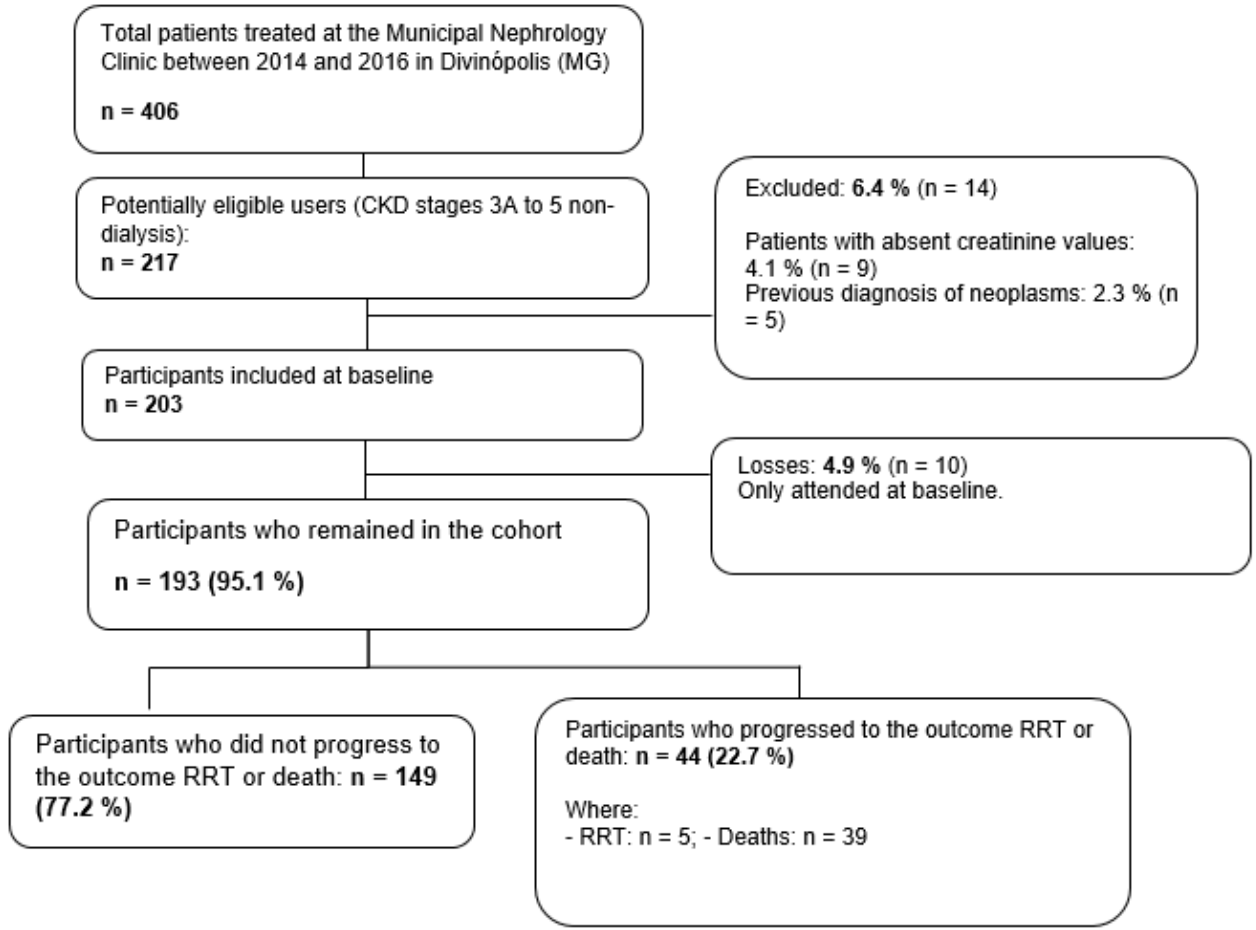
FIGURE 2 - Flowchart of recruitment and follow-up of patients with CKD in stages 3 to 5-ND in Divinópolis (MG),